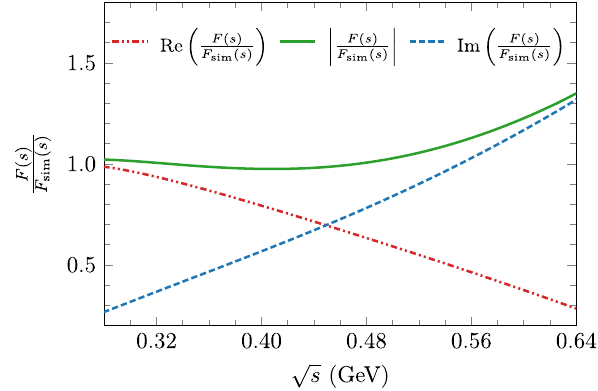
Fig. 9 Absolute value (green solid), real (red dot-dot-dashed) and imaginary (blue dashed) parts of the F ( s )/ F sim ( s ) ratio, as described in the text. The ratio is shown in the physical decay range of s